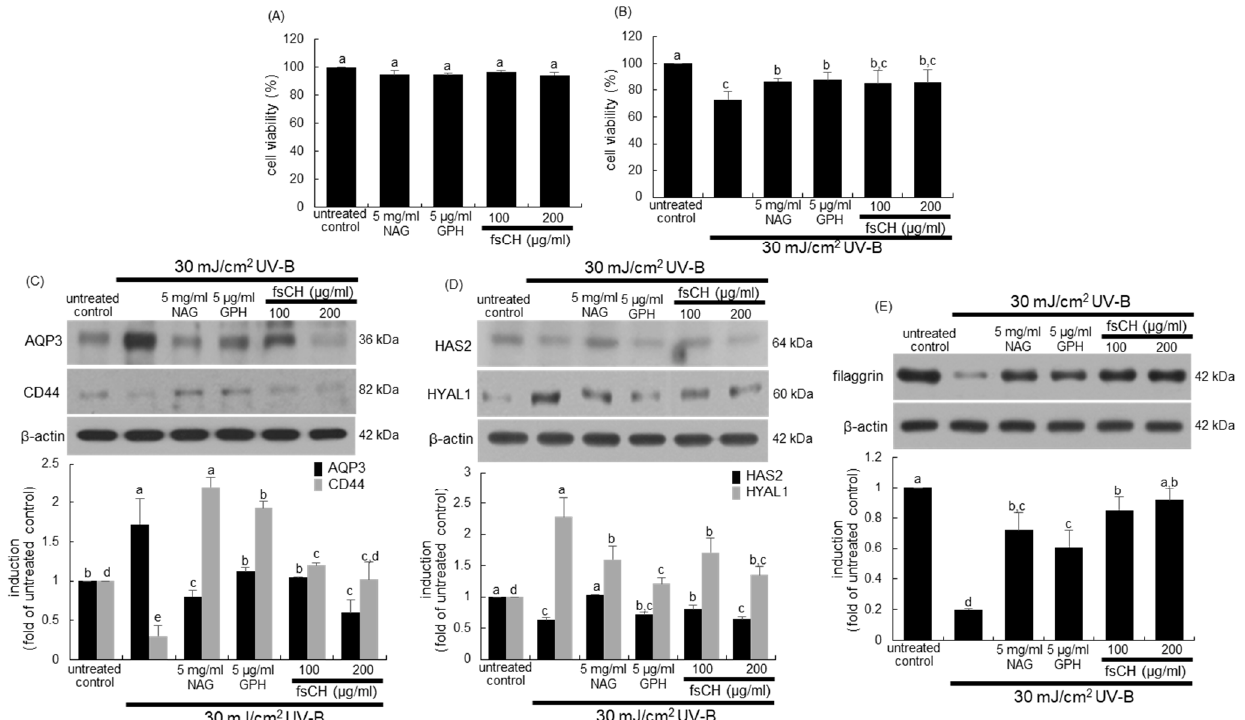
Figure 3. Cytotoxic responses of HaCaT keratinocytes to N-acetyl-D-glucosamine (NAG), glycine-proline-hydroxyproline tripeptide (GPH), and Pangasius hypophthalmus fish skin hydrolysates (fsCH) ( A , B ) and effects of fsCH on target protein levels in the absence and presence of 30 mJ/cm 2 ultraviolet-B (UV-B) irradiation ( C – E ). Human HaCaT keratinocytes were incubated with 5 mg/mL NAG, 5 μ g/mL GPH, and 100–200 μ g/mL fsCH and challenged with UV-B irradiation for two days. Cell viability (mean ± SEM, n = 5) was measured by MTT assay and expressed as the percent cell survival compared to controls ( A , B ). HaCaT cell lysates were electrophoresed on 8–10% SDS-PAGE and subjected to Western blot analysis with a primary antibody against aquaporin 3 (AQP3), CD44, hyaluronic acid synthase 2 (HAS2), hyaluronidase 1 (HYAL1) and filaggrin ( C – E ). β -Actin antibody was used as an internal control. The bar graphs (mean ± SEM, n = 3) in the bottom panels represent quantitative results of the blot bands on top obtained from a densitometer. Respective values in bar graphs not sharing a small letter are different at p < 0.05.